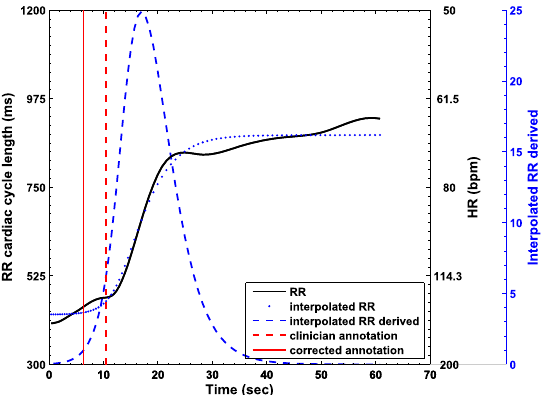
Figure 4. Automatic annotation onset adjustment process. RR time series is represented by the black line. The sigmoid function interpolating the observed RR series is represented by the dotted blue line and its first derivative by the dashed blue line. The vertical red lines represent the onset of the bradycardia proposed by the clinician (dashed line) and the corrected onset (solid line), using the first point where the derivative of the sigmoid adjustment function is greater than 1. In this example, the corrected annotation is located 4.16 s before the one performed by the